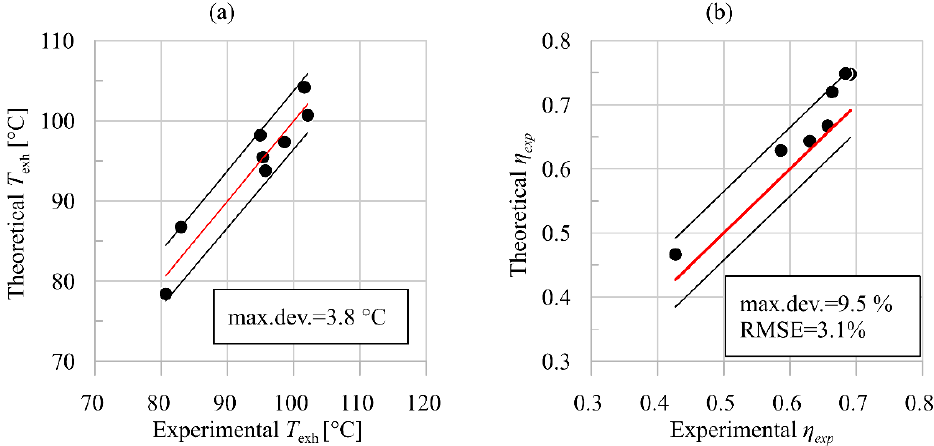
Figure 6. Comparison between experimental and theoretical exhaust temperature T exh ( a ) and expander efficiency η exp ( b ).